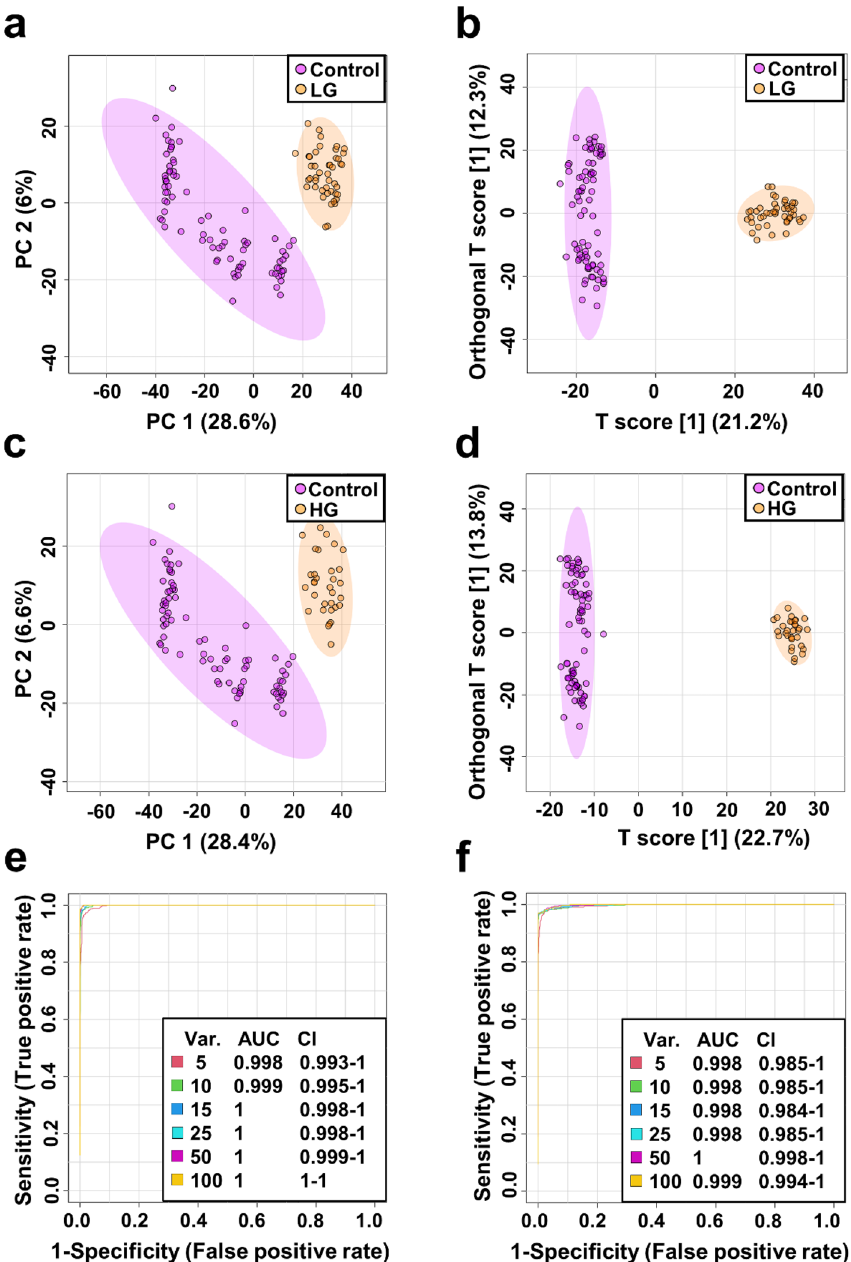
Figure 2. Metabolomic differentiation between different grades of BC and NCs in training set. PCA ( a ) and OPLS-DA ( b ) scores plots of the control (violet) and low-grade (orange). PCA ( c ) and OPLS-DA ( d ) scores plots of the control (violet) and high-grade (orange). ROC curves for LG ( e ) and HG ( f ) BC serum samples vs